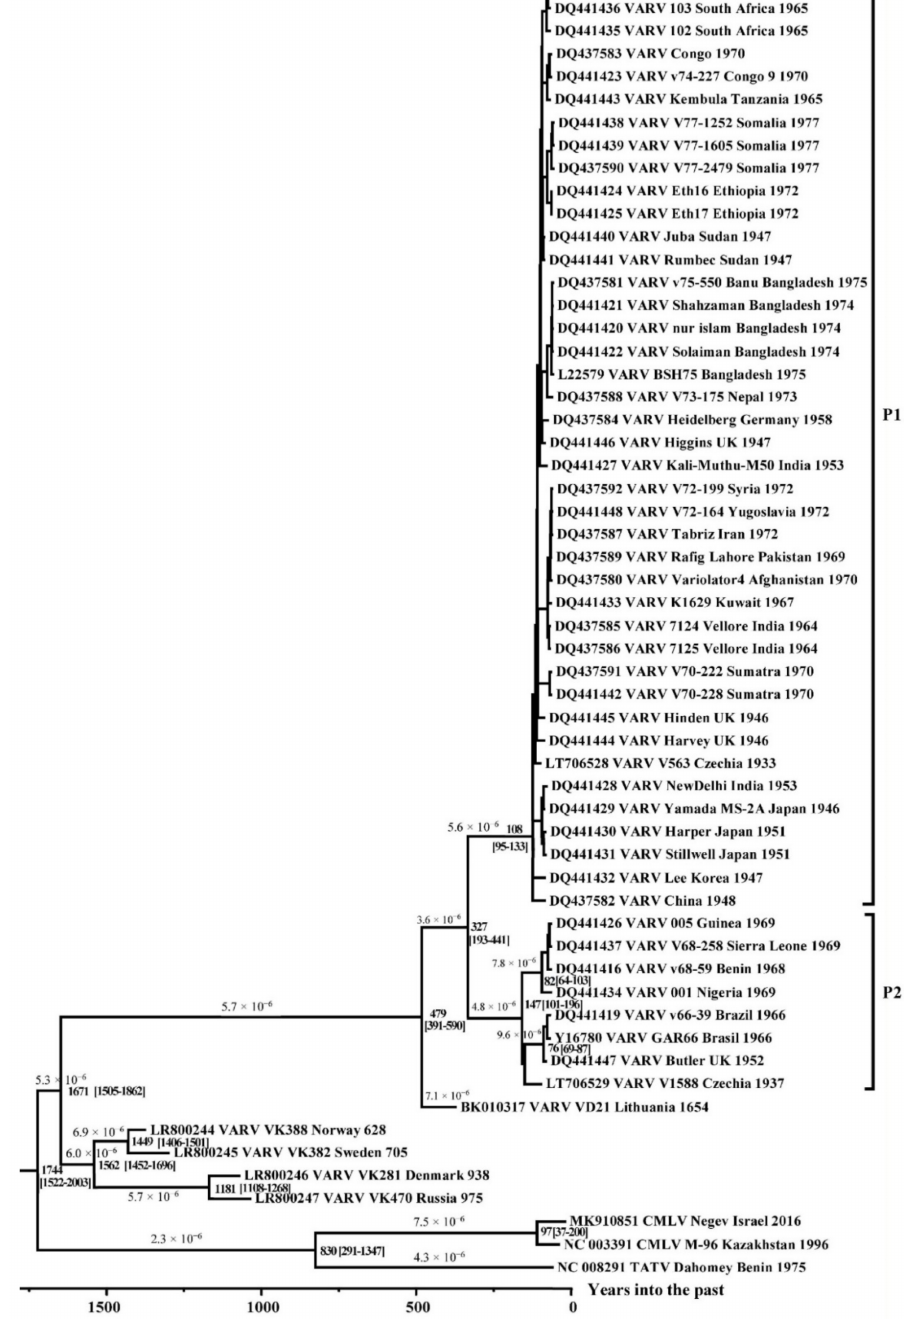
Figure 2. Maximum clade credibility tree for the highly conserved central genome region of